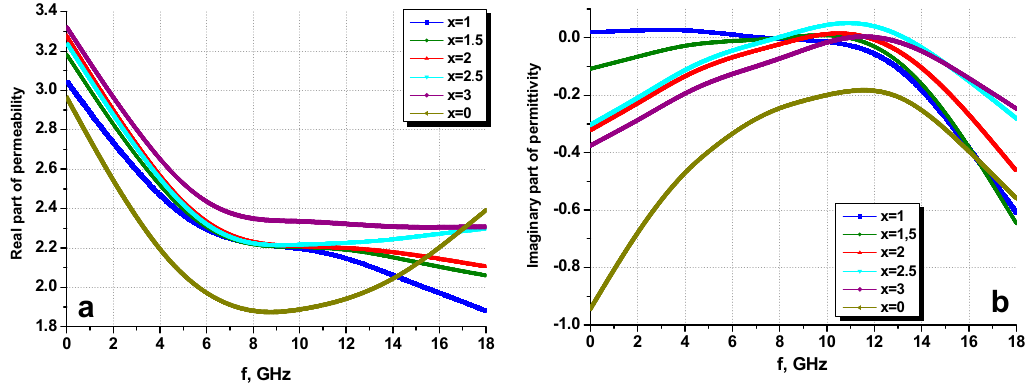
Figure 10. Frequency dispersions of the real part ( a ) and imaginary part ( b ) of permittivity for the SrBaSmFe/(NiZnFe) x NCs.